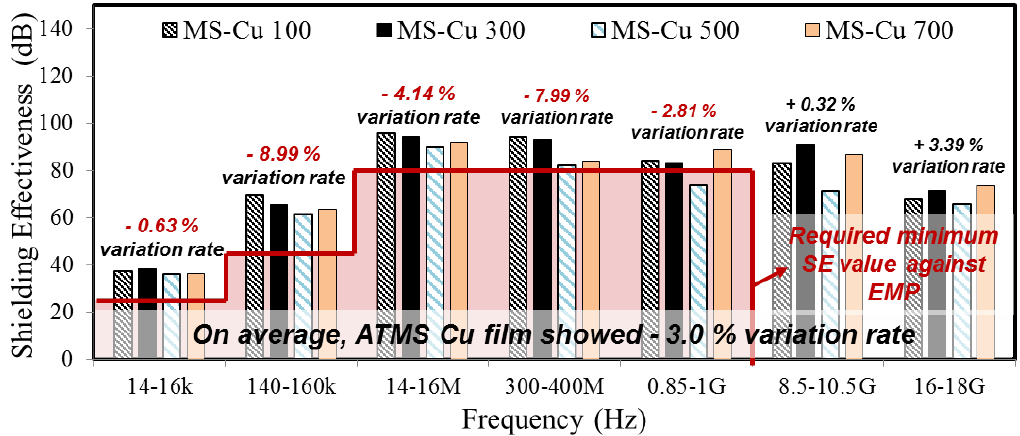
Figure 5. SE test result of ATMS coatings by Cu in regards to thickness.